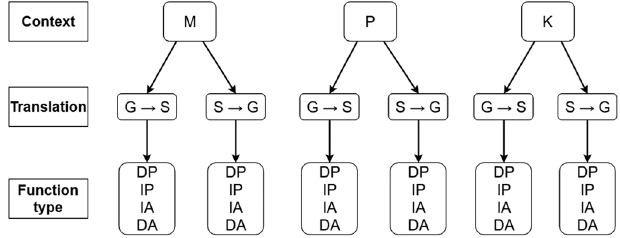
FIG. 1. Schematic overview of the structure of the